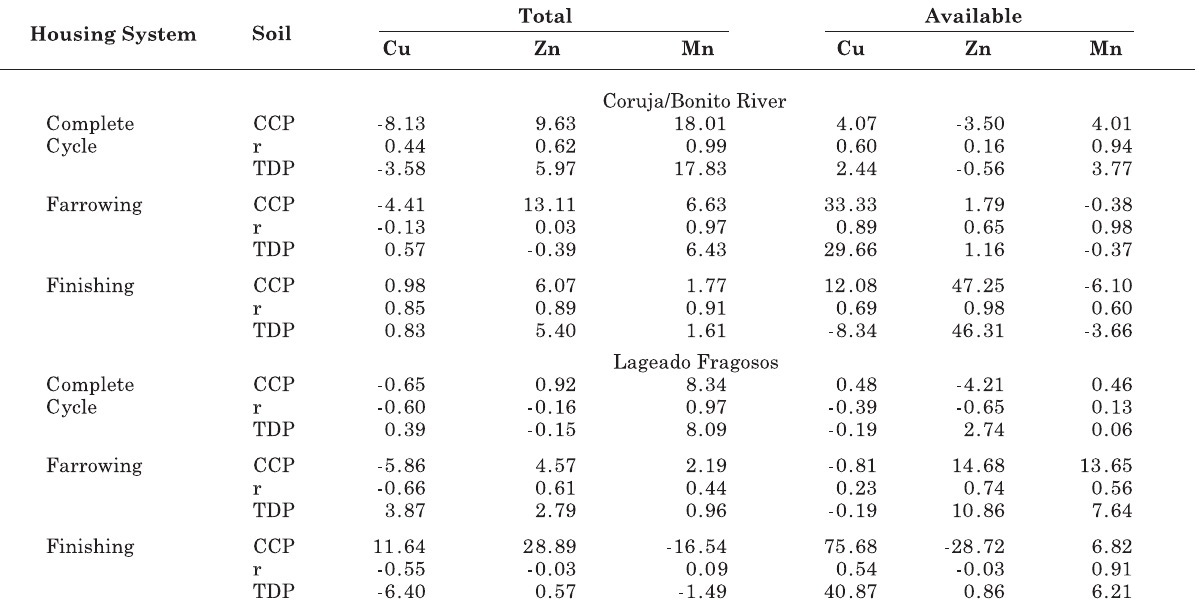
Table 4. Standardized canonical coefficient (SCC), linear correlation coefficient (r) and